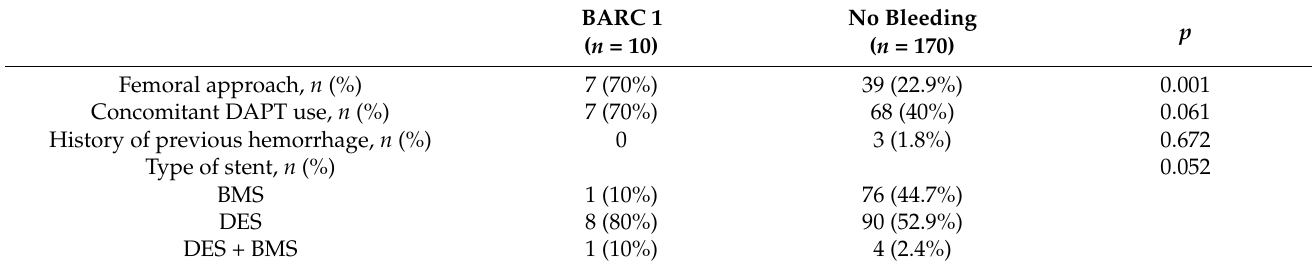
Table 3. Detailed description of bleeding (BARC1).